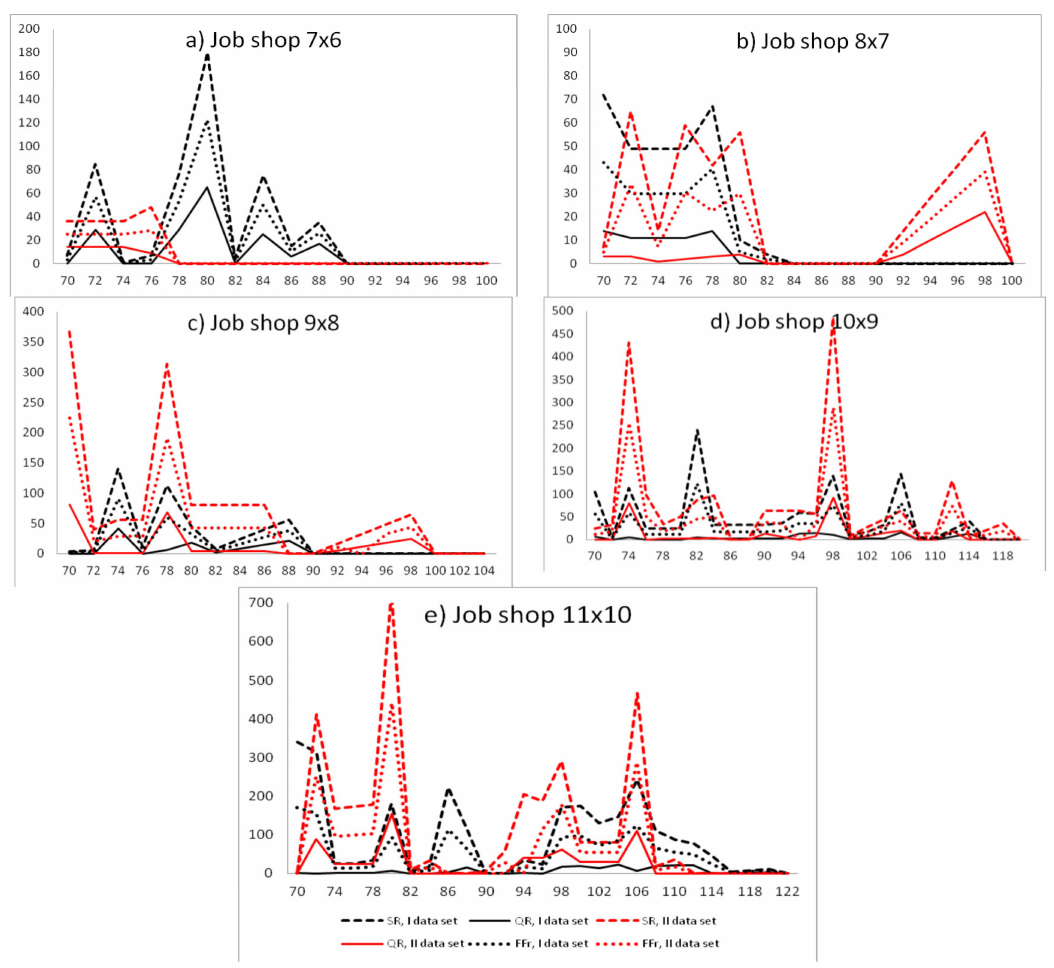
Figure 3. The impact of the critical machine failure time on the solution robustness ( SR ), quality robustness ( QR ) and weighted function ( FF r) of SR and QR for scheduling problems for reliability characteristics obtained using the maximum likelihood method (dataset I) and empirical moments method (dataset